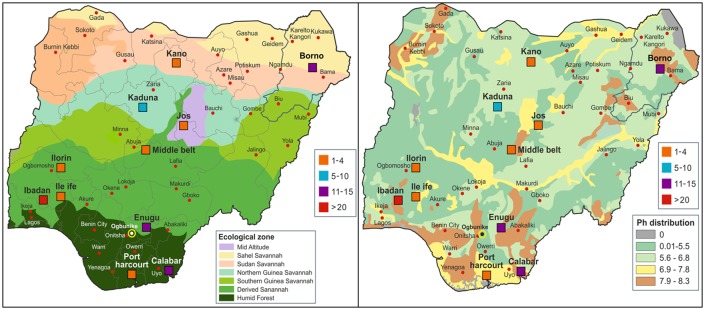
Distribution of reported cases of histoplasmosis in Nigeria in relation to vegetation (A) and soil types (B).